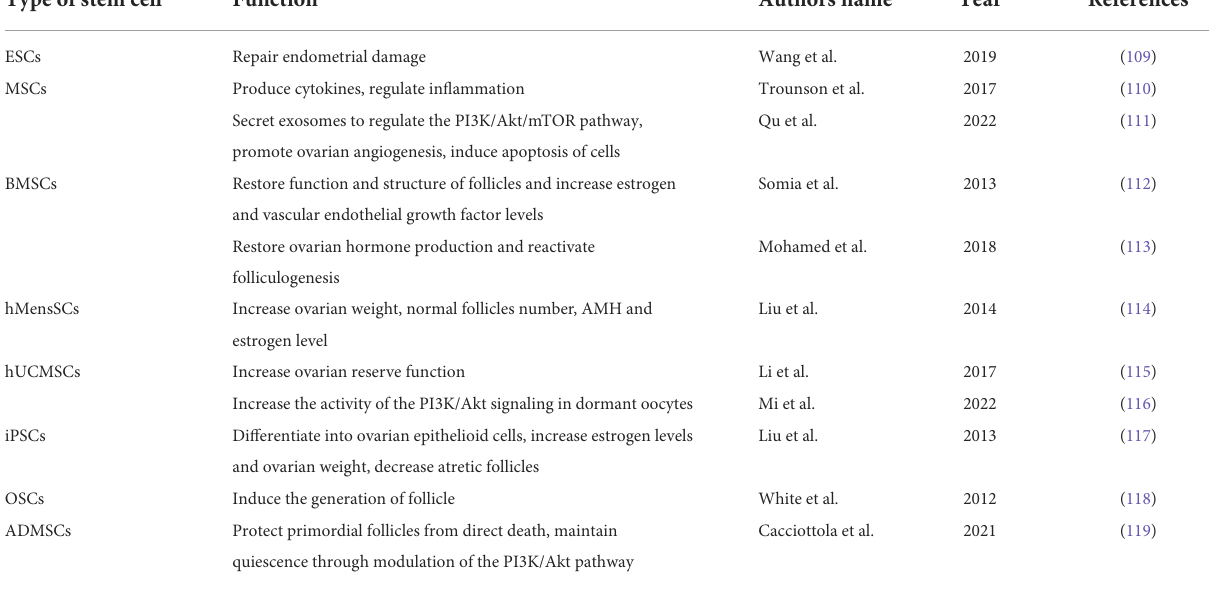
TABLE 1 The applications of stem cells in the treatment of